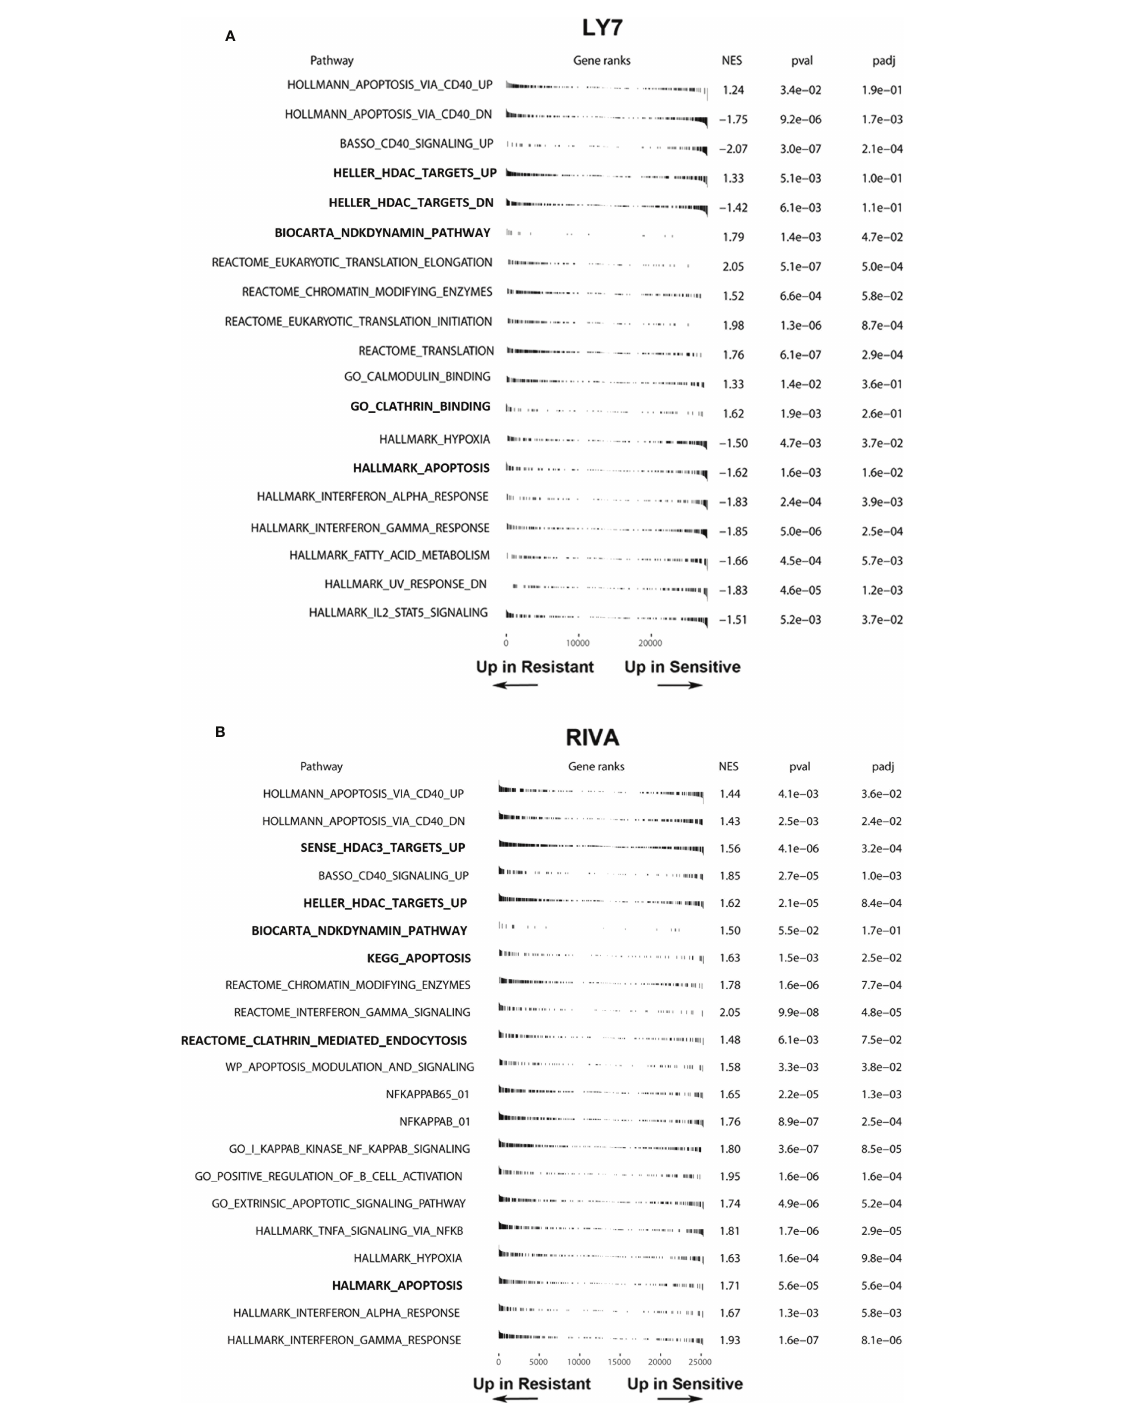
FIGURE 5 Gene set enrichment analysis showing differentially expressed gene sets in parental (sensitive) and engineered resistant LY7 (A) and RIVA (B) cells. Normalized enrichment scores, raw and adjusted p-values of apoptosis, endocytosis and HDAC-related gene-sets are shown. Plots indicate the positions of genes from a given gene set in a list of differentially expressed genes ranked by the value of Wald statistics. NES, Normalized Enrichment Score; padj, adjusted